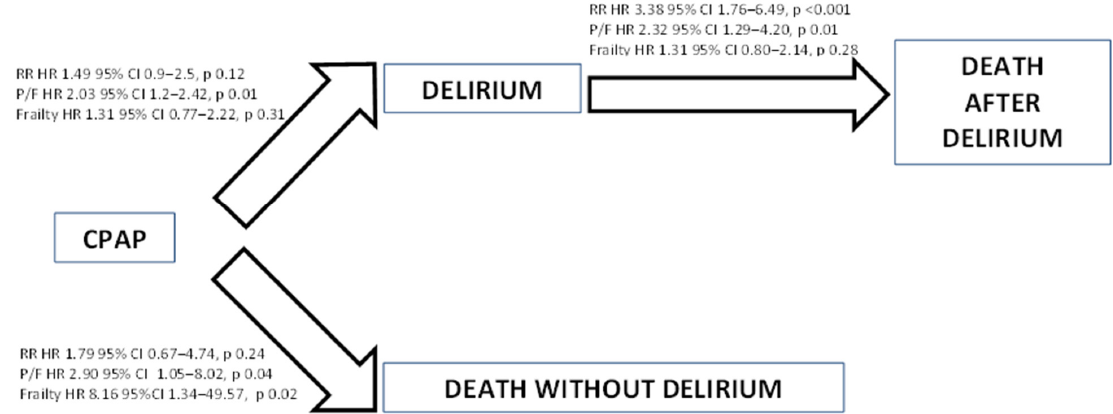
Figure 2. Illness ‐ death model by baseline characteristics on transition to different states. Figure 2. Illness-death model by baseline characteristics on transition to different